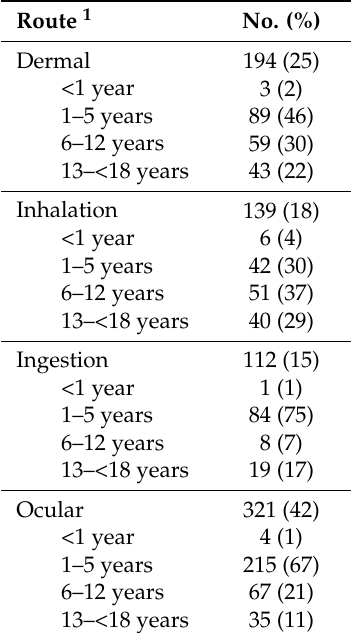
Table 5. Distribution of events in childhood reported by primary route of exposure and age group.